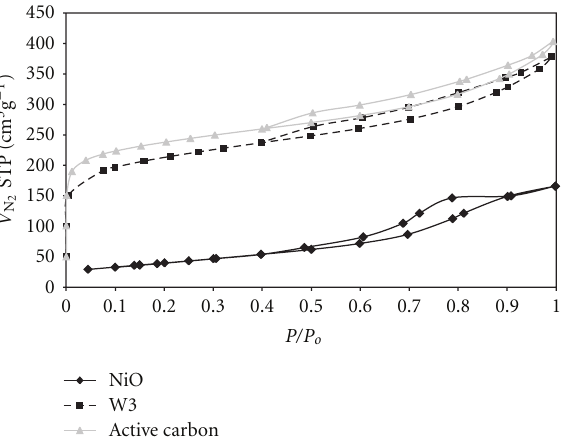
Figure 5: Pore-size distributions of NiO, composite W3, and active